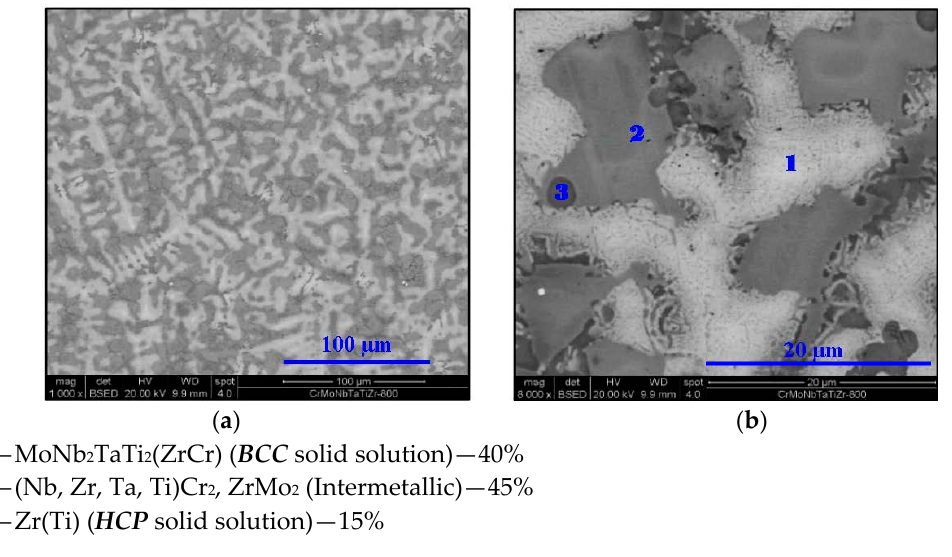
Figure 4 . SEM micrograph of Cr 20 Mo 10 Nb 20 Ta 10 Ti 20 Zr 20 at 800 °C at ( a ) 1000× and ( b ) 8000× magnifications Figure 4. SEM micrograph of Cr 20 Mo 10 Nb 20 Ta 10 Ti 20 Zr 20 at 800 ◦ C at ( a ) 1000 × and ( b ) 8000 × in BSE mode. magnifications in BSE